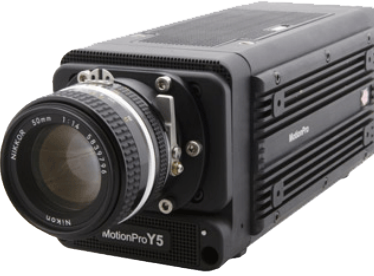
Figure 6. High-Speed Camera.